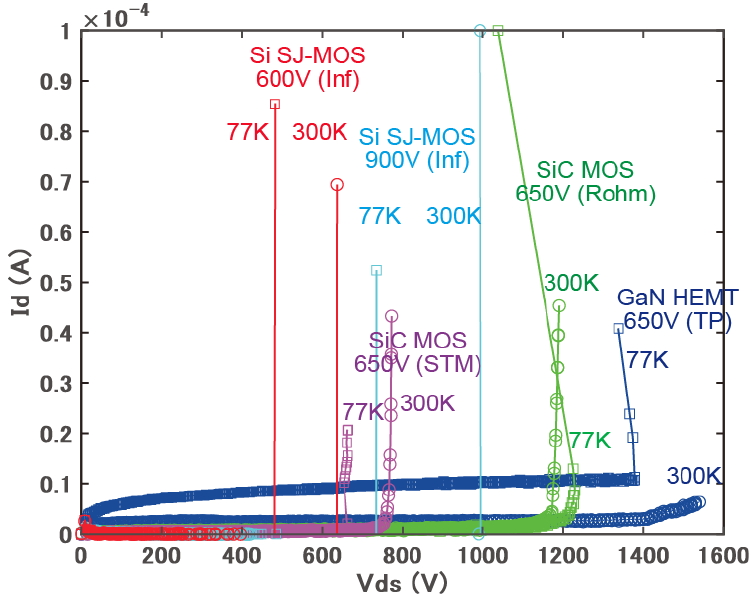
Figure 10. Experimentally-measured breakdown characteristics at 300 K and 77 K.